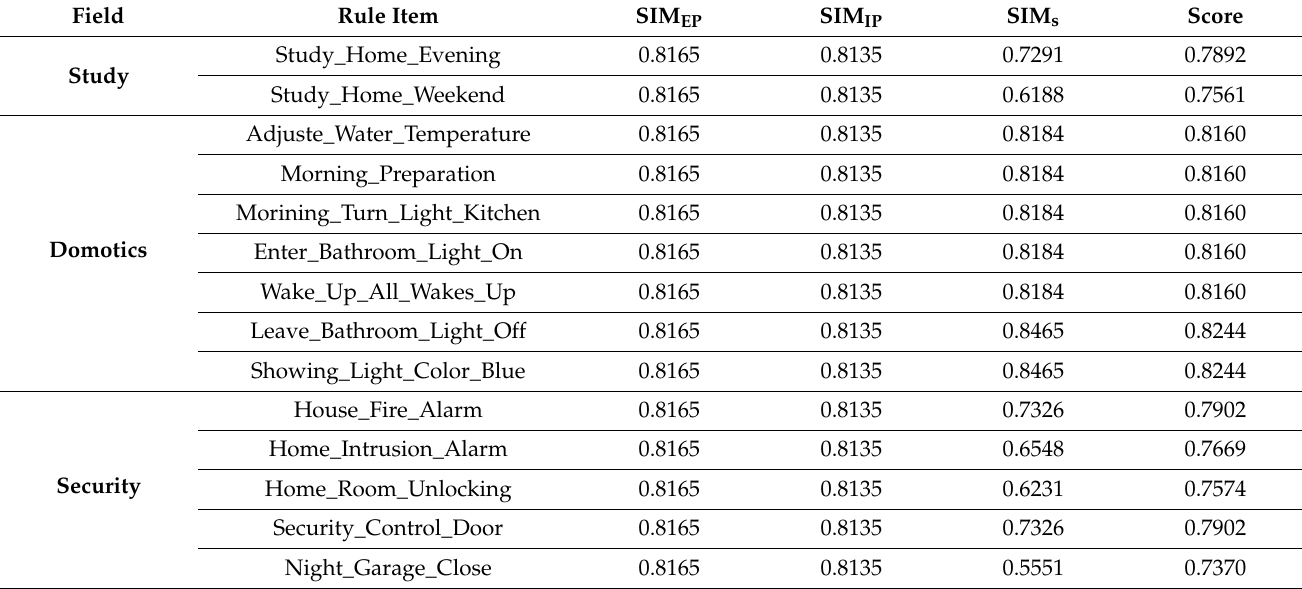
Table 2. List of recommended rules with first preferences configuration and context (home).